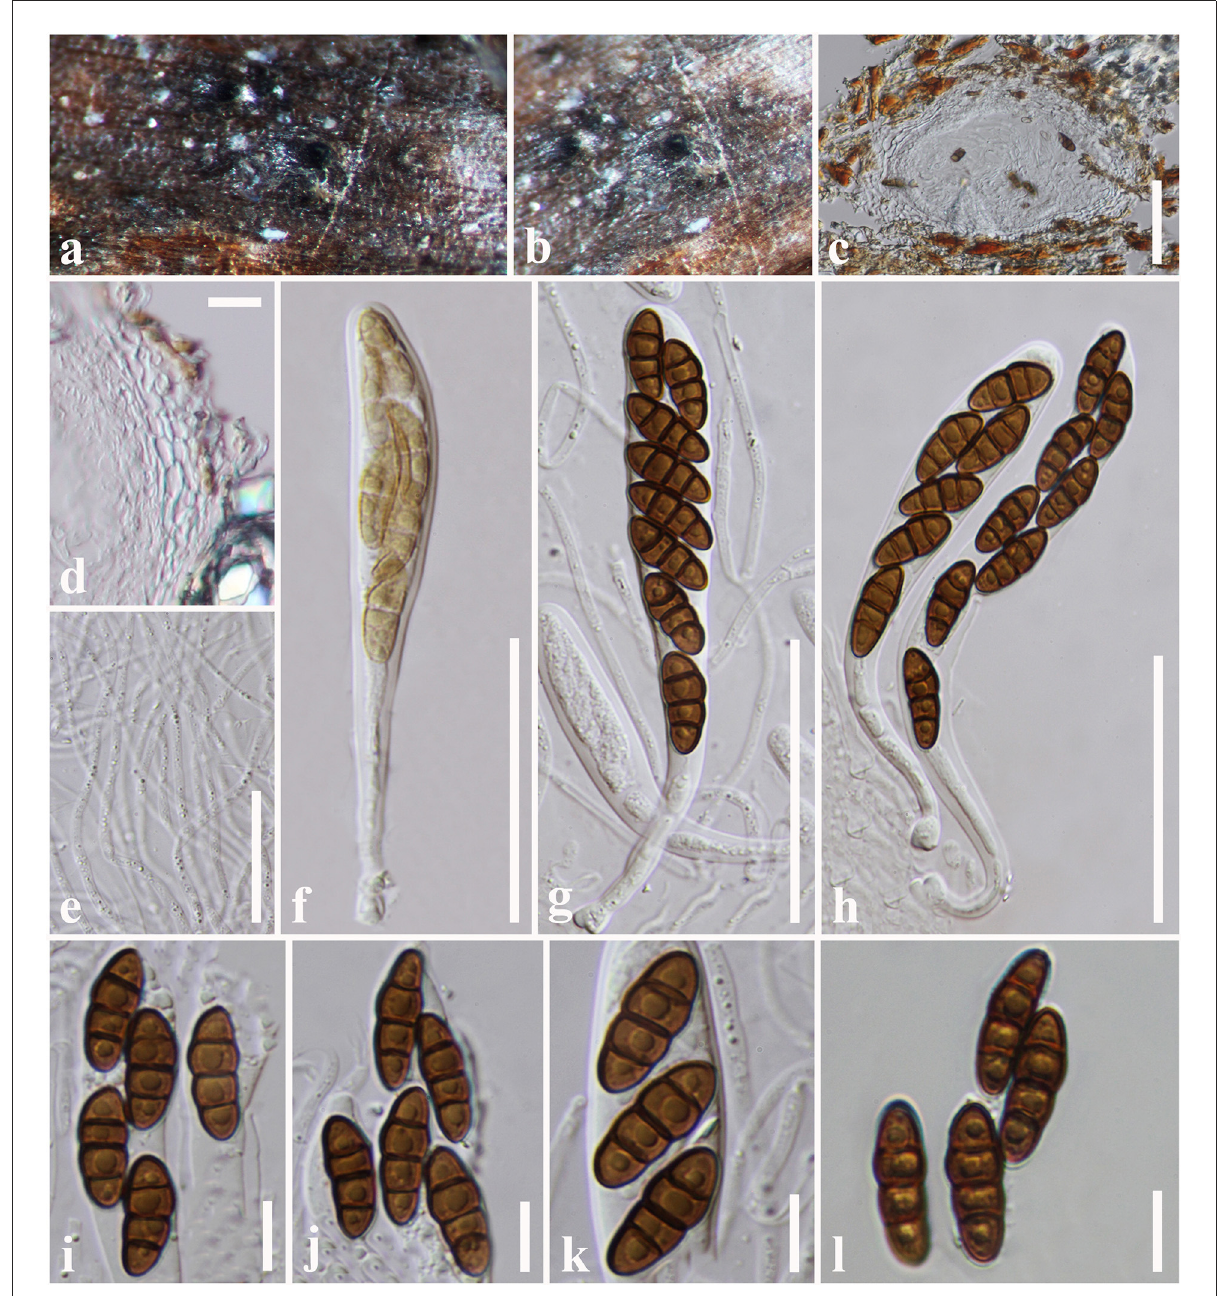
FIGURE3 Montagnula jonesii (MFLU 18-0084, new host record). (a,b) Ascomata on a dead stem of Ficus benjamina . (c) Vertical section through an ascoma. (d) Peridium. (e) Pseudoparaphyses. (f–h) Asci. (i–l) Ascospores. Scale bars: (c) = 50 µ m, (d) = 10 µ m, (e–h) = 30 µ m, (i–l) = 8 µ m.